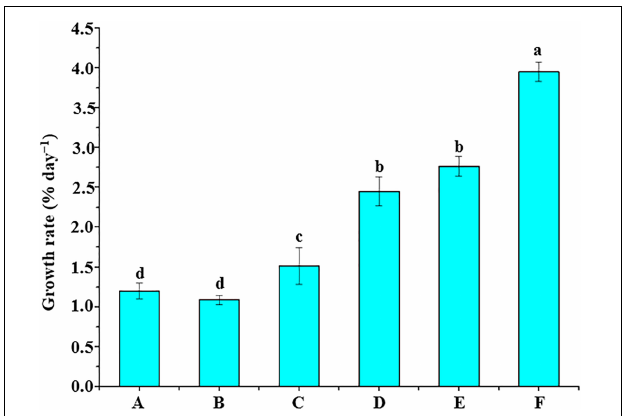
FIGURE 4 | Supernatant of bacterial culture and U. fasciata (WSB) growth promotion test. A group added sterile seawater, B group added sterile 2216E liquid medium, C group added the supernatant of the strain B. cereus U5-30 living in 2216E, D group added the supernatant of the strain Hyunsoonleella sp. HU1-3 living in 2216E, E group added the supernatant of the strain B. cereus U5-30 living in 2216E + L-tryptophan, F group added the supernatant of the strain Hyunsoonleella sp. HU1-3 living in 2216E + L-tryptophan. The difference coefficient represents the difference between A and F